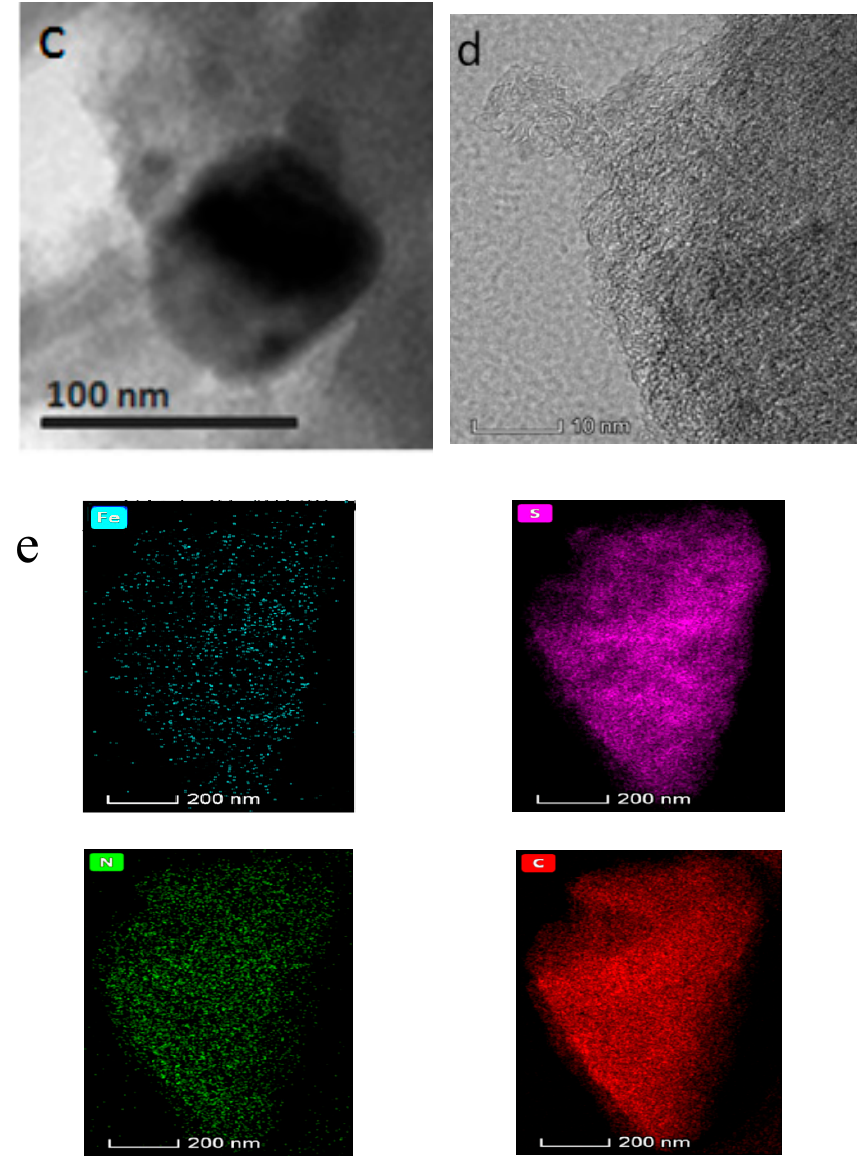
Figure 9. ( a , b ) SEM images of Fe-ZIF-8. ( c ) SEM images of Fe/S@N/C-0.5. ( d ) TEM of Fe/S@N/C-0.5. ( e ) HAADF-STEM mapping of Fe/S@N/C-0.5.